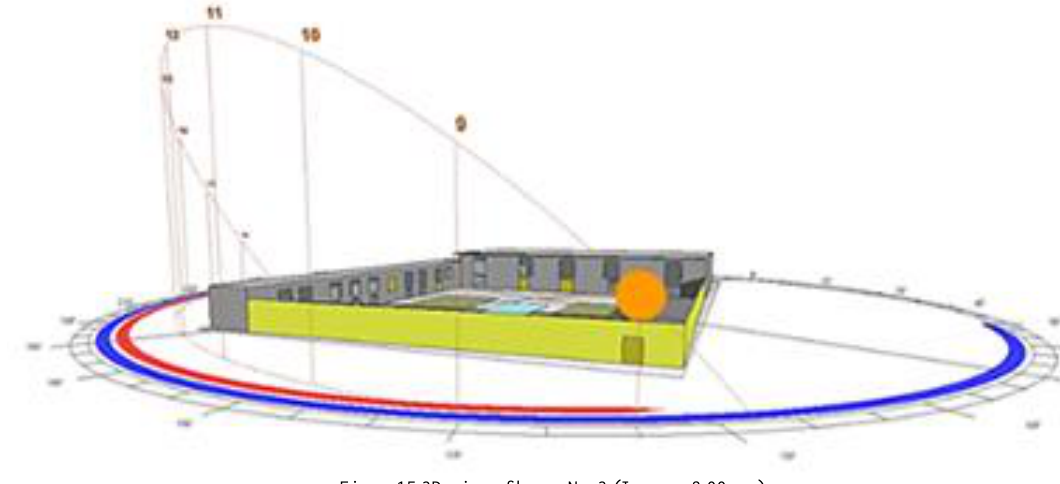
Figure 15 3D view of house No.3 (January, 8:00 am)